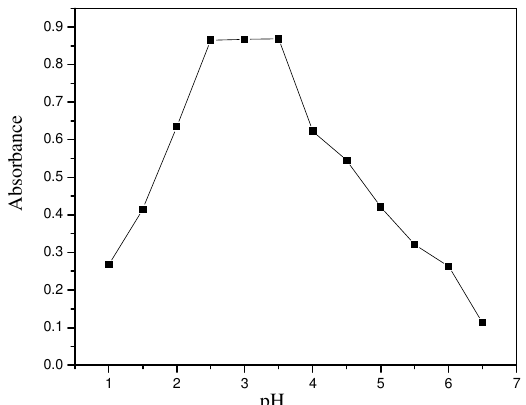
Figure 2. Effect of pH on Pd(II) - 3,4-DHBINH complex; Pd(II):1 mL of 1.0×10 −4 M; 3,4-DHBINH: 1.0 mL of 1.0×10 −3 M; λ